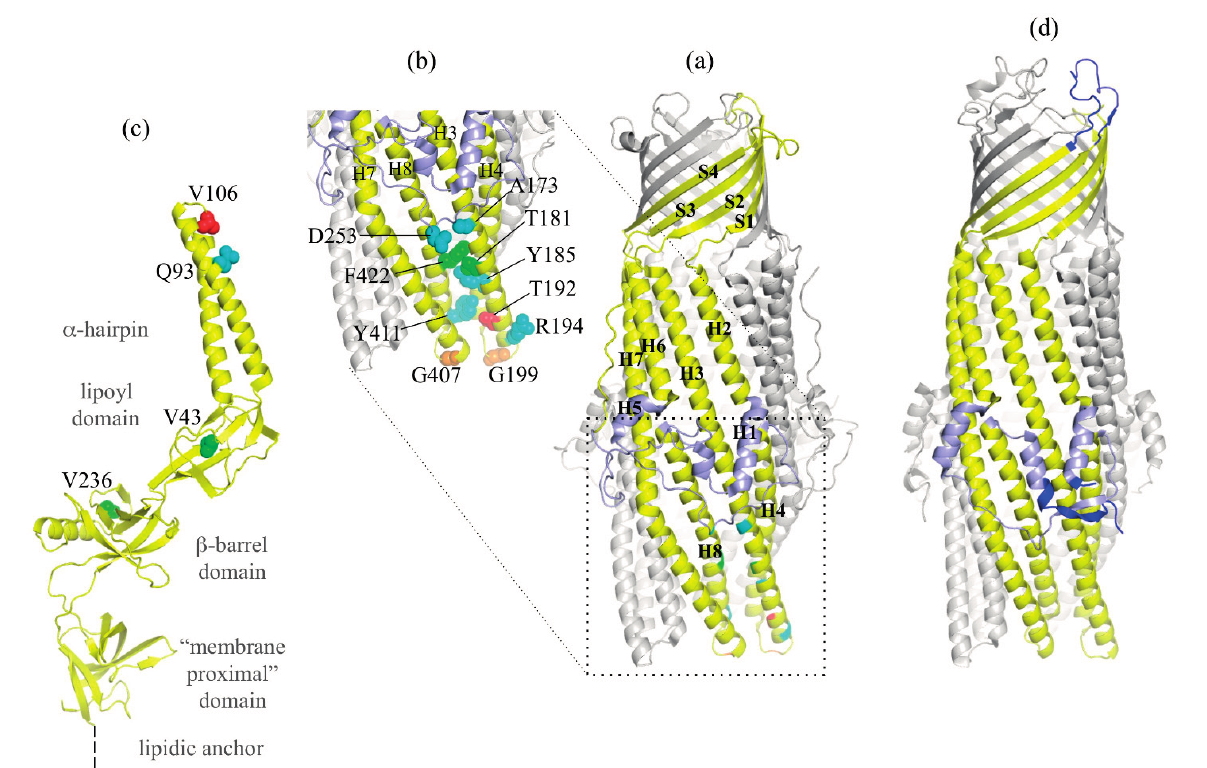
Figure 3. OprM structure with reported gain of function mutants and α -coiled-coil domain mutations. ( a ) Cartoon representation of the OprM trimer with two monomers colored in grey and one monomer colored in yellow with the equatorial domain in light blue. The secondary structure adopted is indicated. ( b ) Zoom of the OprM α -coiled-coil domain. Residues colored in blue (A173, Y185, D253, Y411, and R194) correspond to the equivalent positions of the TolC mutants making TolC functional with MexAB. Residues colored in green (T181I and F422I) correspond to the OprM mutations suppressing the MexA-V106M loss of function. The residue colored in red (T192) corresponds to a loss of expression of OprM. Residues colored in orange (G199A and G407A) correspond to non-functional mutants. ( c ) Cartoon representation of one monomer of the MexA structure (PDB code 2V4D) [55] with the three residues cited in the text presented in sphere. V106, whose mutation in methionine leads to a non-functional MexAB-OprM pump, is in red. V43 and V236, whose mutation respectively in methionine and phenylalanine restore the loss of function of MexB-G220S, are in green. Q93, whose mutation in arginine makes MexA able to function with OprN, is in blue. ( d ) Cartoon representation of TolC for comparison with the same color code as in OprM, with the exception of the three regions largely different from OprM structure (N-terminus, extracellular loop and C-terminus), colored in